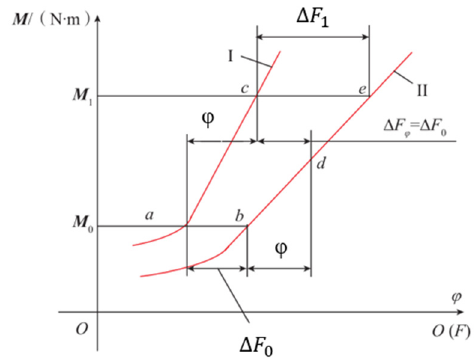
Figure 15. Torque corner method of tightening bolts [79].